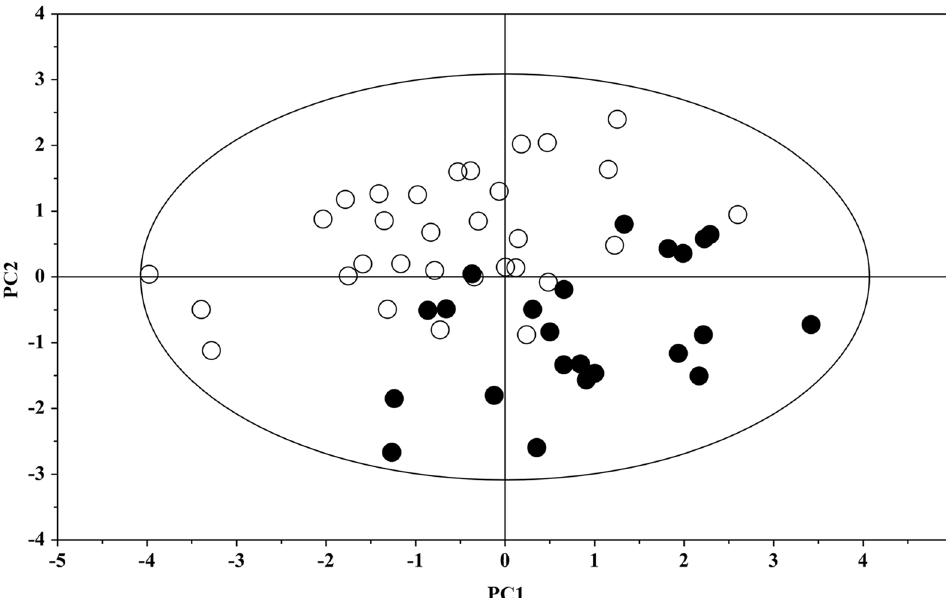
Figure 3. PCA scores plot built with only identified significant metabolites: Controls (full circle), IEI-EMF subject (open